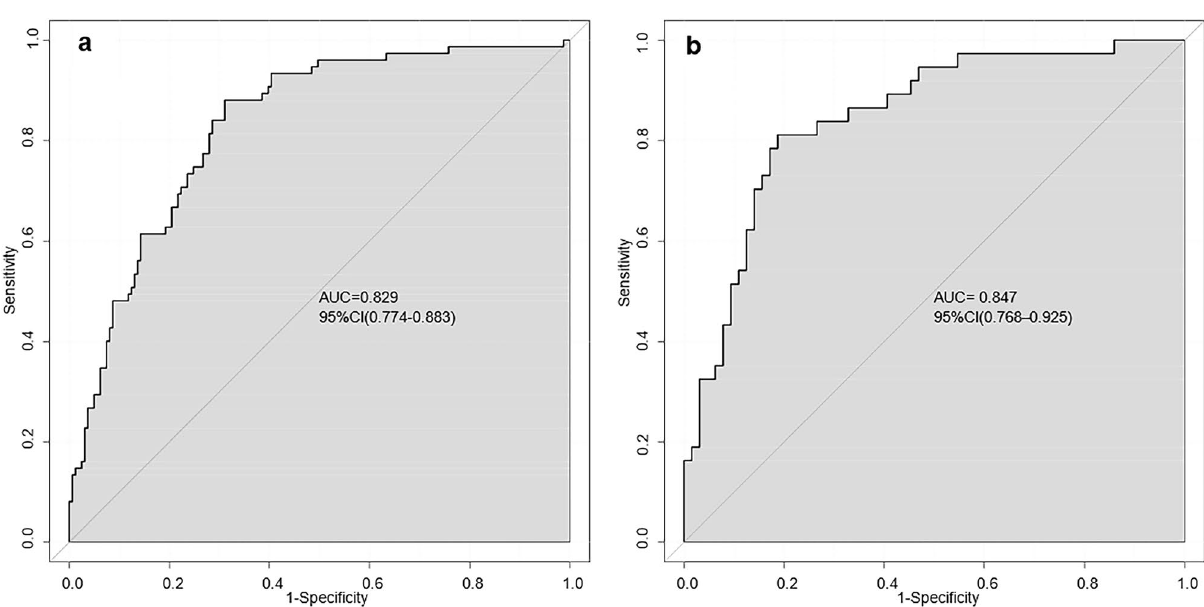
Figure 3. AUROC of the nomogram model (( a ) training set, ( b ) validation set). The closer the AUROC is to 1, the more reliable the predictive ability of the